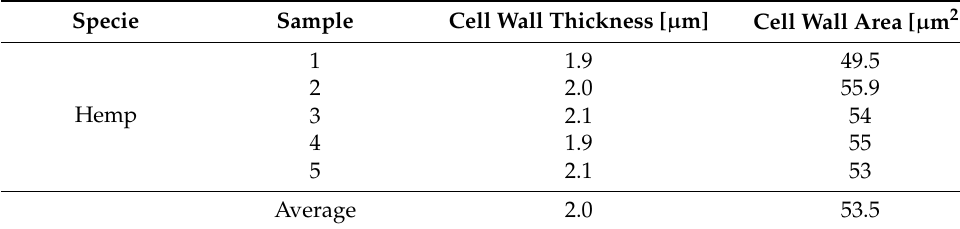
Table 4. Thickness and area of the cell wall of